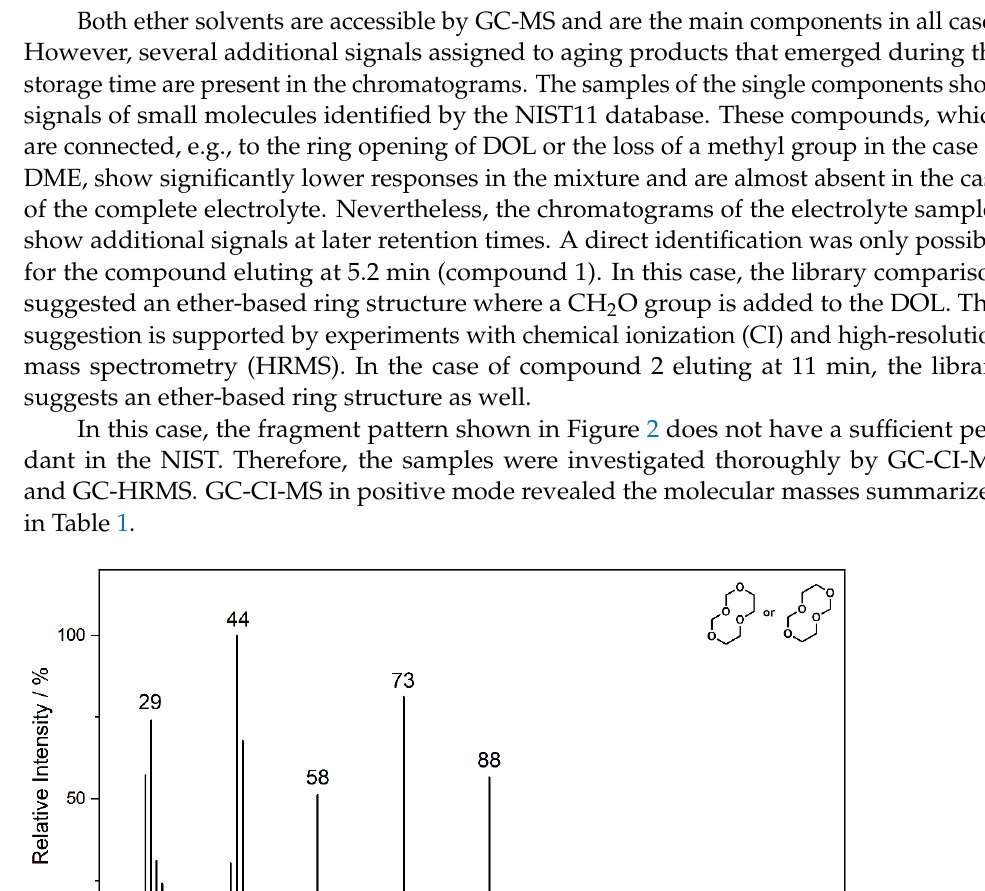
Figure 2. Fragment spectrum obtained by GC-MS of compound 2 eluting at 10.9 min and labeled as indicated in Figure 1. The m / z ratio of prominent fragments is given at the respective signals.